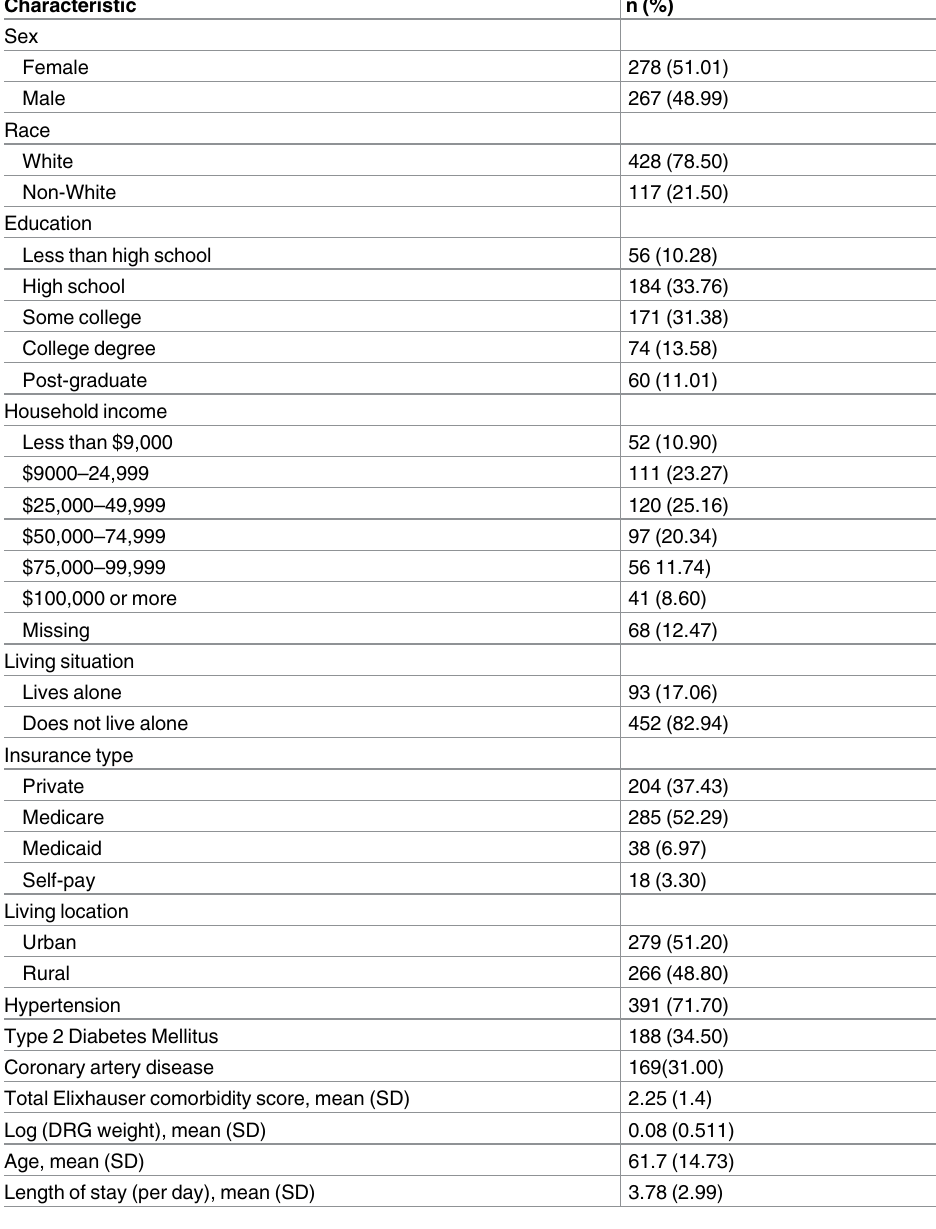
urban (Table 1). Hypertension, diabetes mellitus type 2, and coronary artery disease were among the most common diagnoses, the mean Diagnosis Related Group (DRG) weight was 0.08, and the mean Elixhauser comorbidity score was 2.25. In the bivariate chi-square analysis (Table 2), we observed a higher incidence of AEs when patients had their first scheduled post-discharge follow-up outpatient visit within 7 days (33.5%) than patients with visits of greater than 7 days (23%), p = 0.007. Table 1. Patient